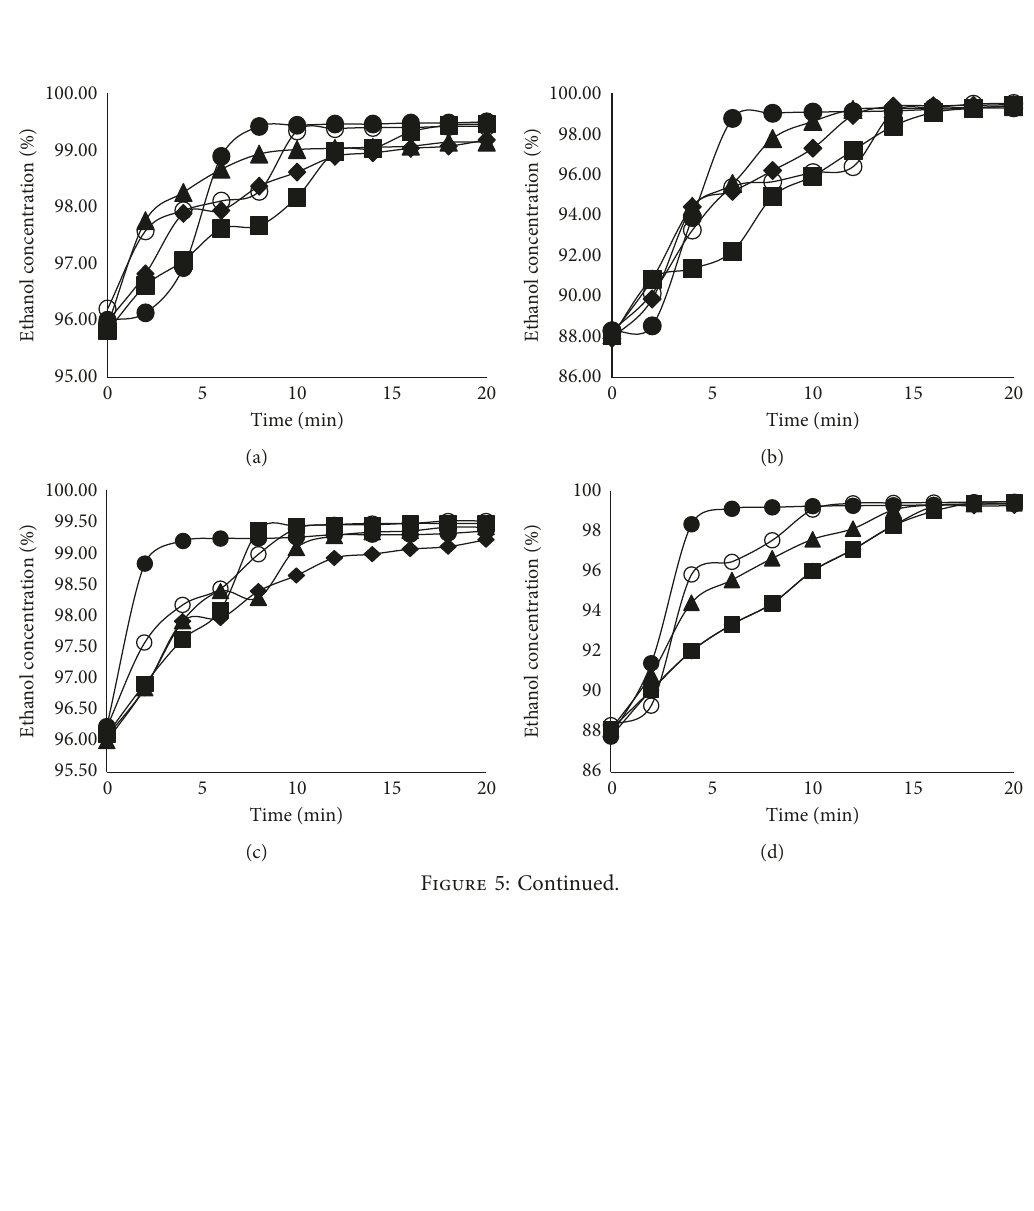
at 22 ° C; , q at 30 ° C; ■ , q at 40 ° C; , q eks eks eks mod